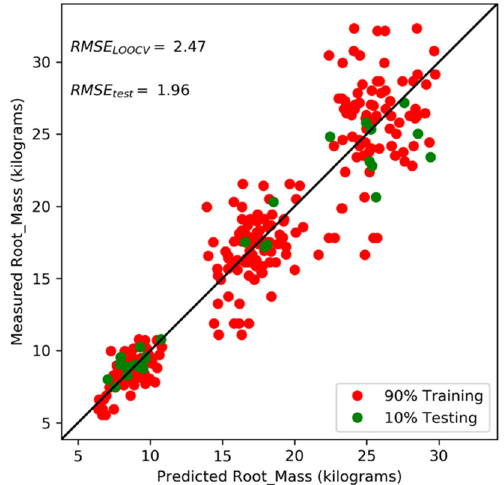
Figure 9. Measured vs. predicted table beet root mass for the 2018 canopy closing VDVI + Area multiple linear regression model based on area-augmented plot imagery. The model is trained with 90% (red) and tested with the remaining 10% (green) area-augmented study plot imagery. RMSE are displayed for the training data using leave-one-out cross-validation and for the unseen test data.